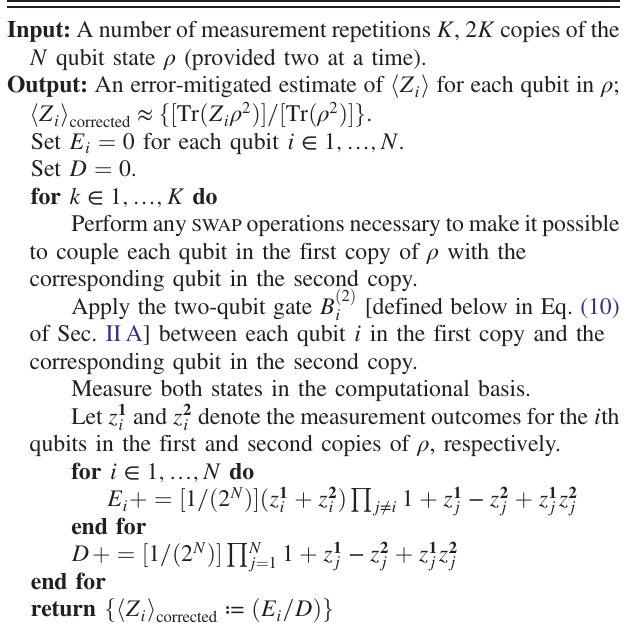
Algorithm 1. Virtual distillation, basic implementation (see Sec. II A).